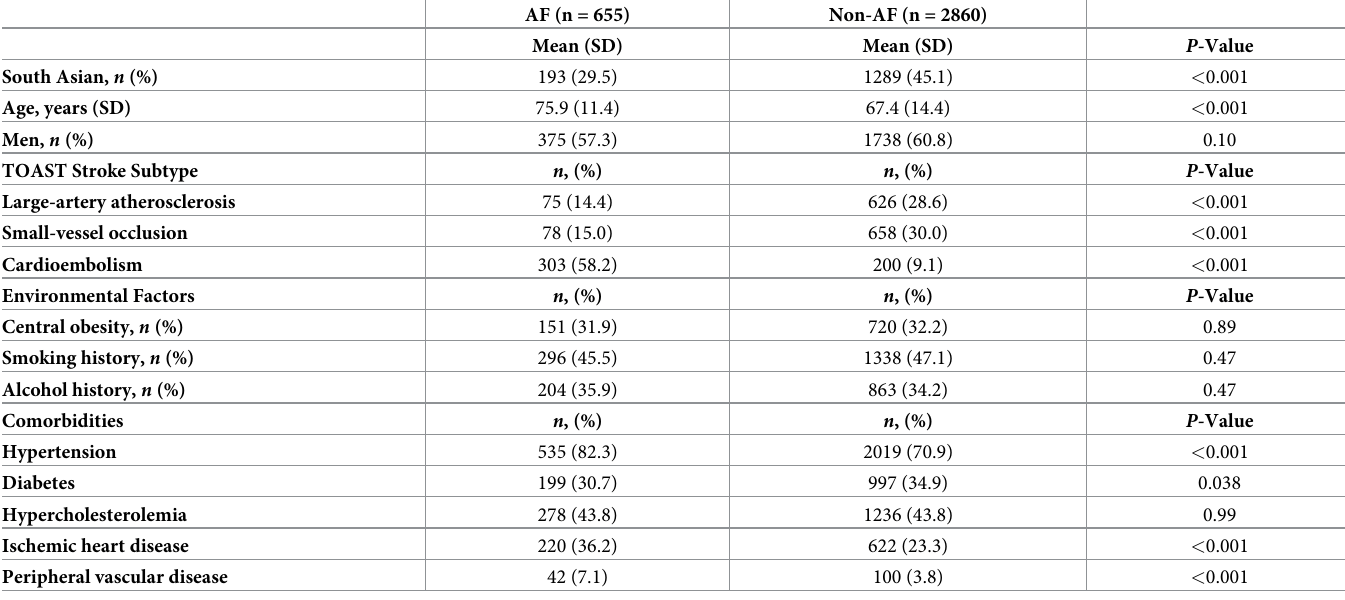
Table 1. Ischemic stroke population characteristics stratified by atrial fibrillation (AF)